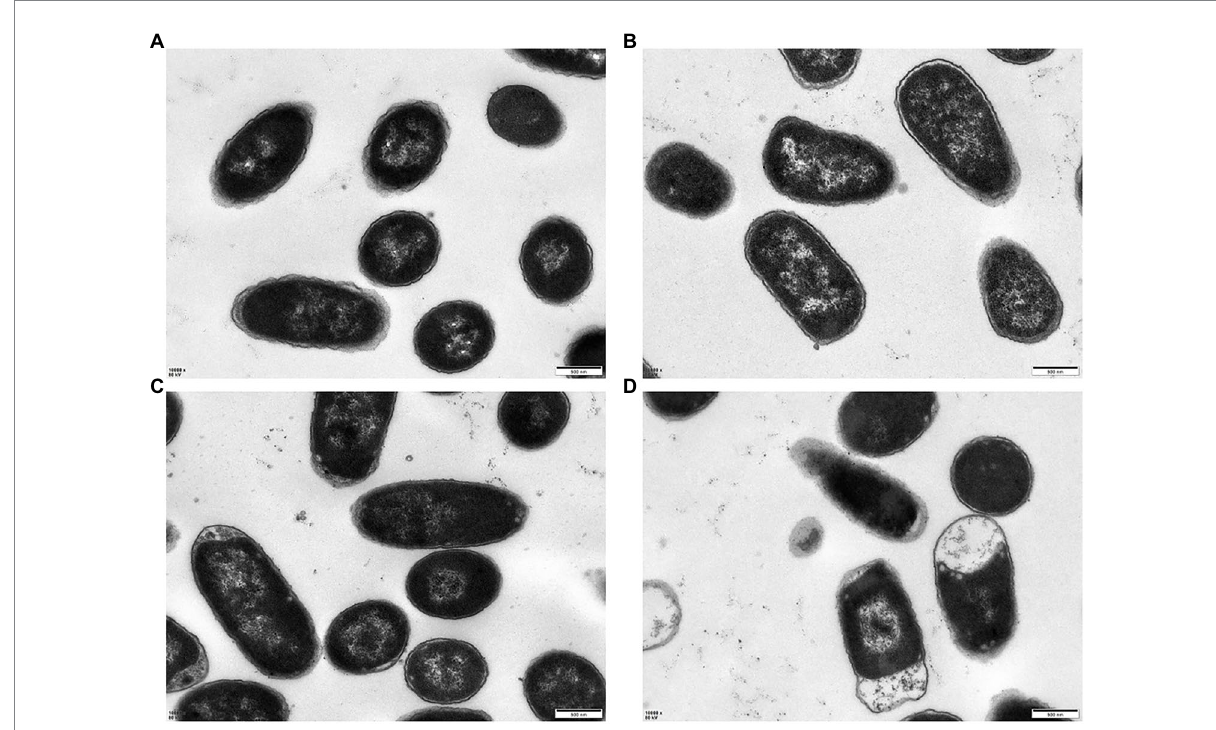
FIGURE 4 TEM images of Escherichia coli K12 and JW5917 treated with (C,D) and without (A,B) plantaricin BM-1 (magnification: